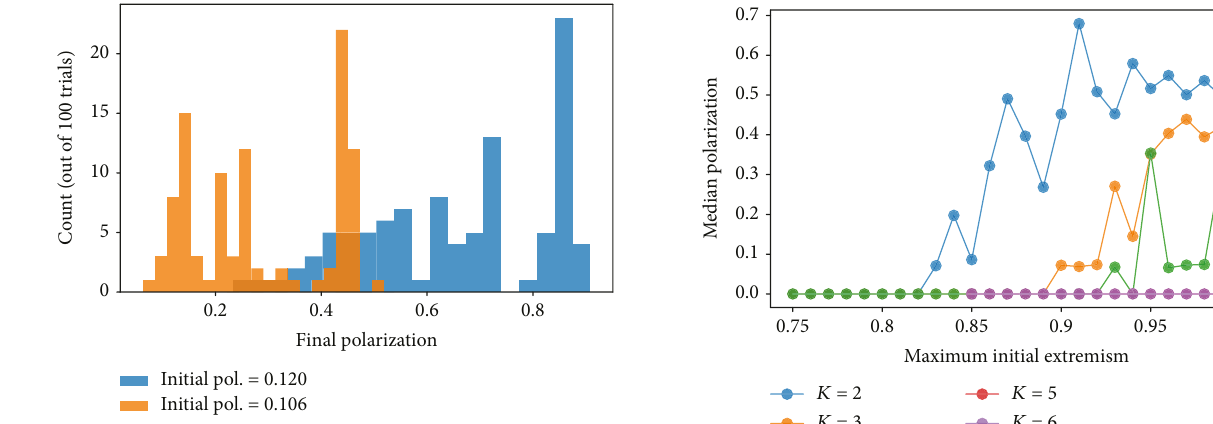
Figure 6: Distribution of fi nal polarizations at t = 10 4 starting from initial conditions of either maximum or minimum polarization taken from the connected caveman trials with K = 2 .